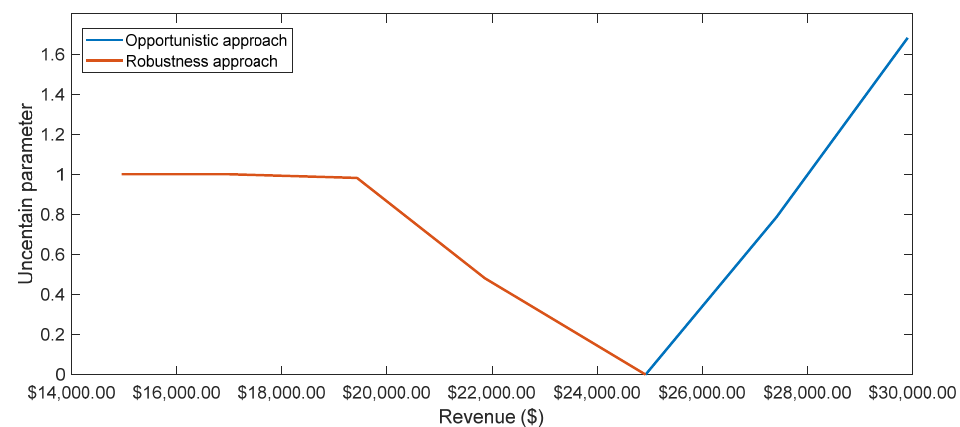
Figure 4. The effect of solar generation uncertainty on the target revenue. Table 3. The effect of solar generation fluctuation on the target revenue.